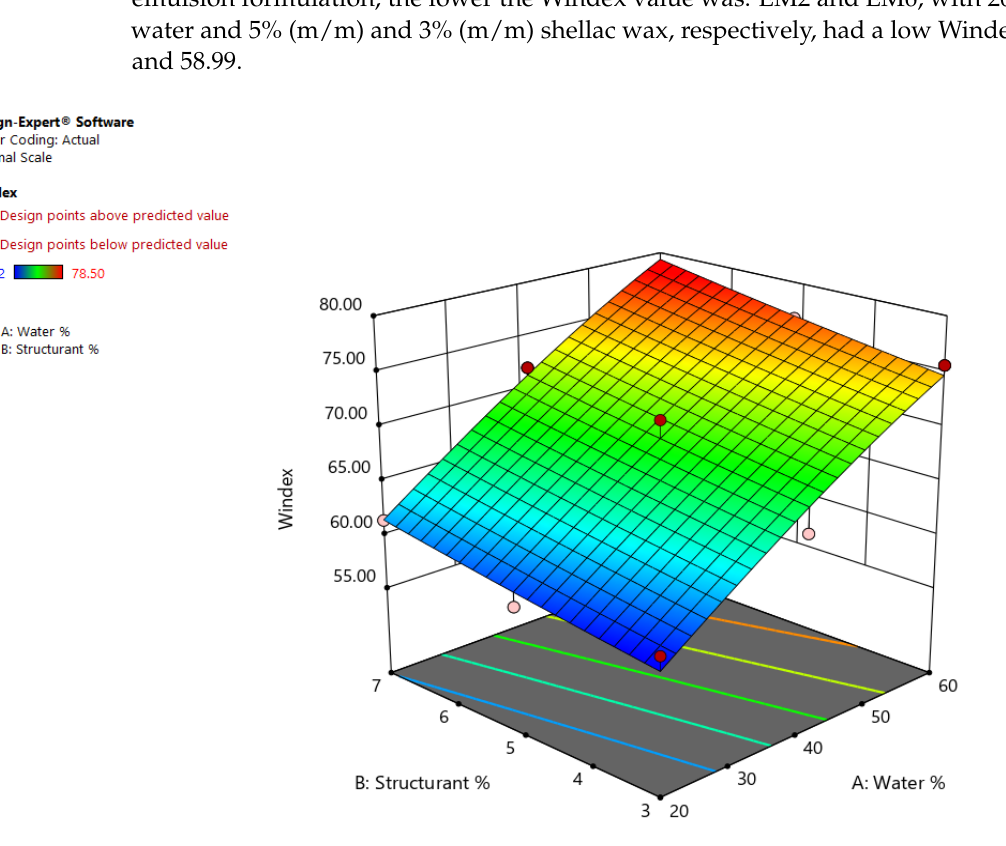
Figure 7. Effects of wax and water concentration on the calculated Whiteness index of shellac wax oleogel emulsions.